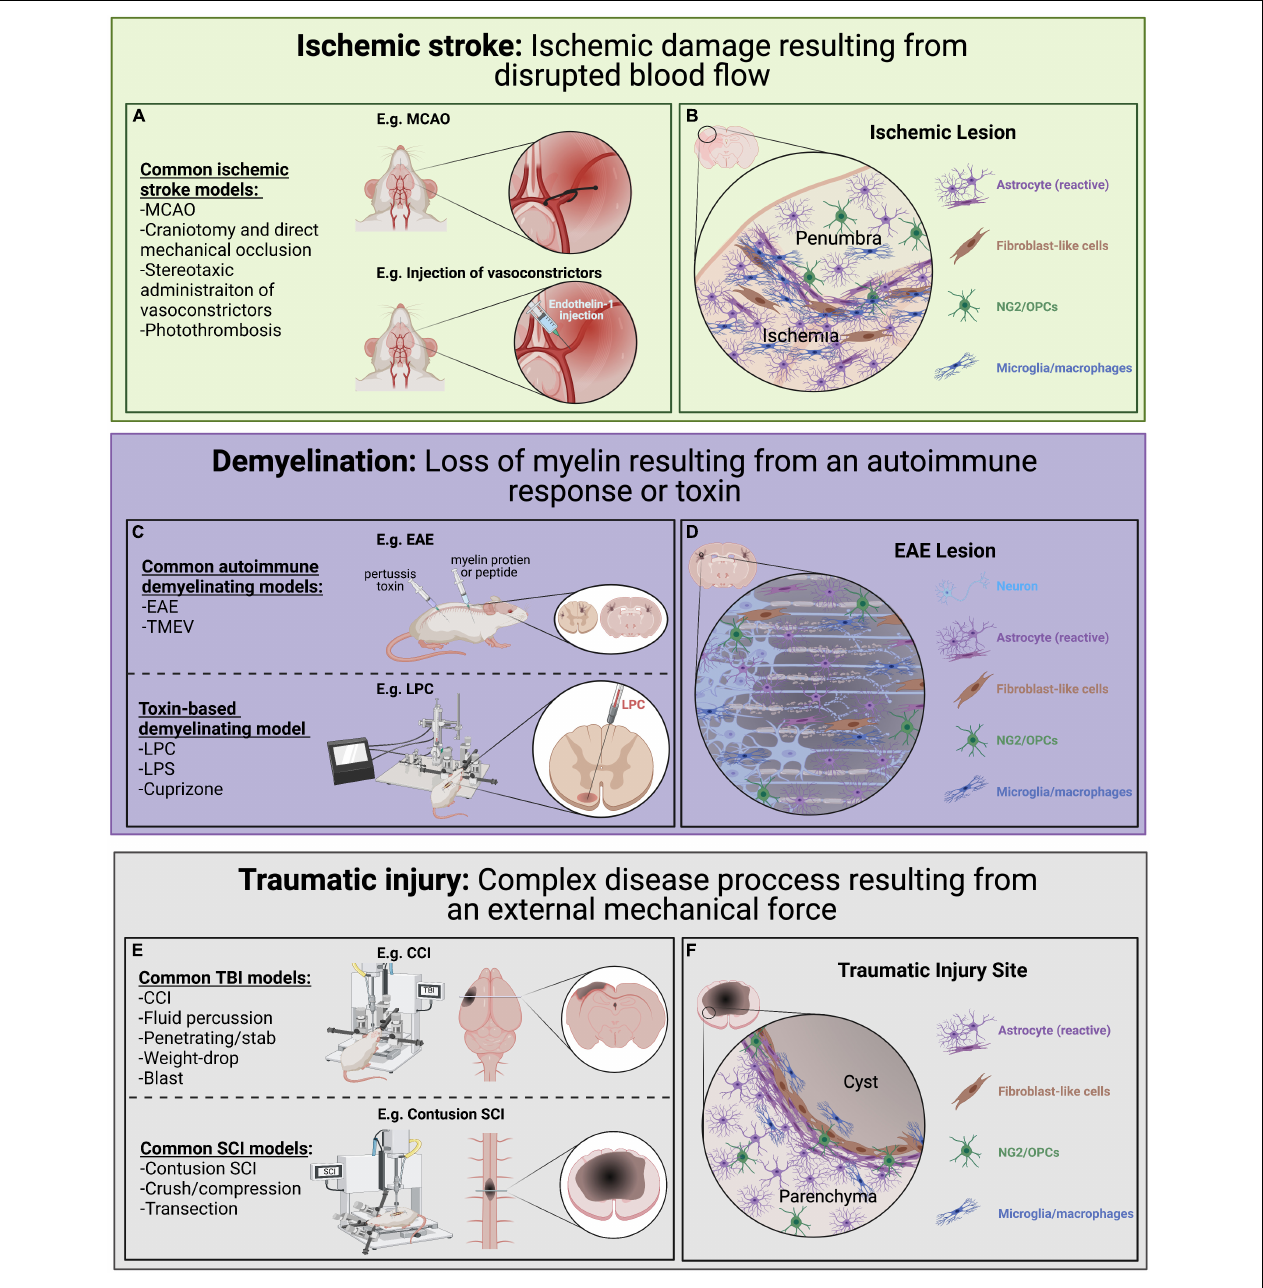
FIGURE 3 | Pre-clinical models of ischemic stroke, CNS demyelination, and traumatic injury used to look at astrocyte diversity. Each of these models have advantages and disadvantages with regards to modeling human disease and induce diverse astrocyte injury responses. (A) Common ischemic stroke models. Ischemic stroke results from disrupted blood flow leading to ischemic damage, cell death and associated loss of function. Common animal models of ischemic stroke involve the transient or sustained blockade of normal blood flow to an area of the brain through occlusion of a blood vessel (e.g., MCAO). (B) A simplified illustration of an ischemic lesion where the ischemic area is predominately populated by immune cells and reactive astrocytes with a slow gradient toward an inner cluster of microglia/macrophages and surrounded by an outer layer of astrocytes. (C) Common demyelination models can be initiated through either an autoimmunity-based or toxin-based route, each highlighting different pathological features and chosen based on the research questions being pursued. (D) A simplified illustration of an EAE induced lesion where there is a loss of oligodendrocytes and their myelin sheaths (beige) within the lesion. Demyelination lesions are often filled with immune cells, including microglia/macrophages, and NG2/OPCs which contribute to repair. In the situation where remyelination does not take place, axon degeneration can result. (E) Common traumatic injury models focusing on different mechanical injuries applied to the brain and spinal cord, each with its own complex secondary injury cascade. (F) A simplified illustration of a typical CNS traumatic injury where a pronounced secondary injury cascade often leads to the loss of tissue (sometimes forming a fluid-filled cyst) at injury epicenter. Generally, there is an inner accumulation of fibroblast-like cells closest to epicenter surrounded by densely packed reactive astrocytes which have an important role in protecting the parenchyma